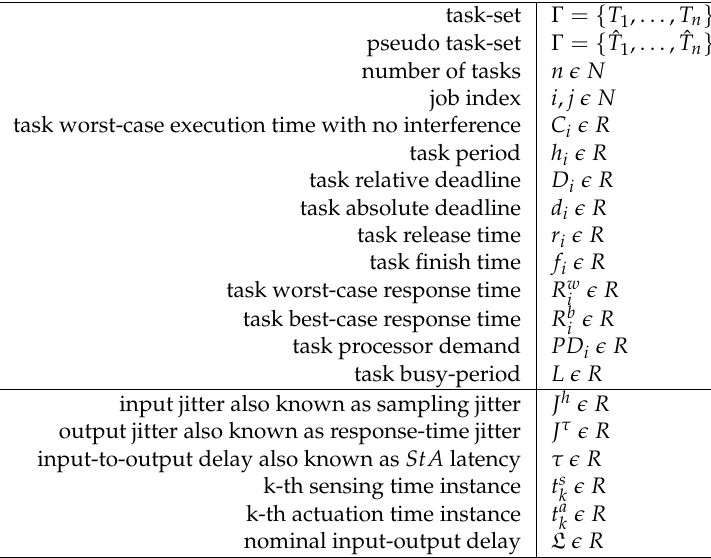
Table 1. Notations used in the